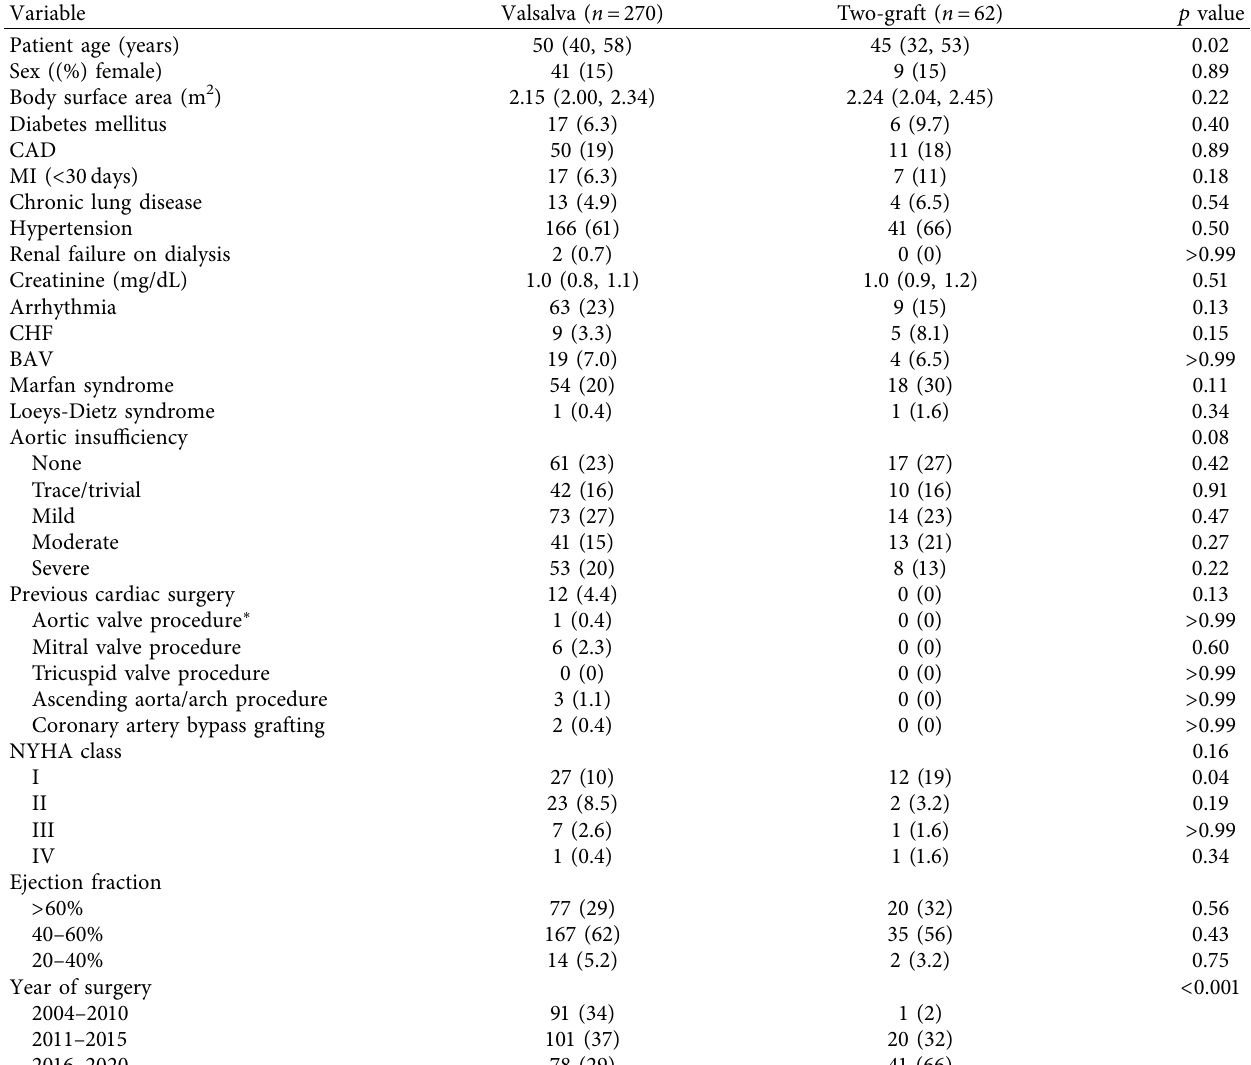
Table 1: Preoperative and demographic